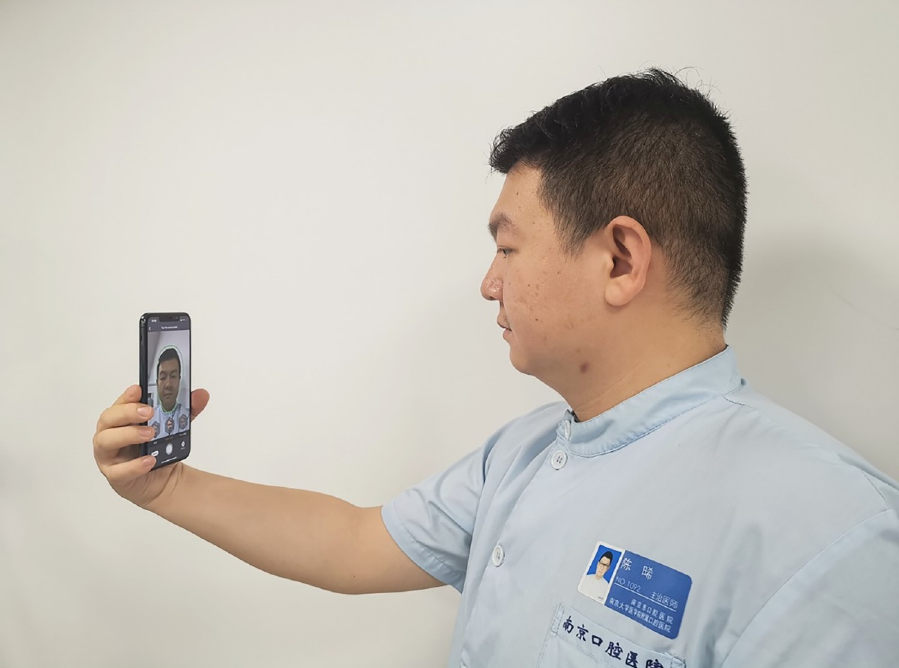
Fig 1. 3D face scan by using scanning APP. Participant taking 3D face scan with scanning APP installed on a smartphone. Whole process cost less than 1 minute.